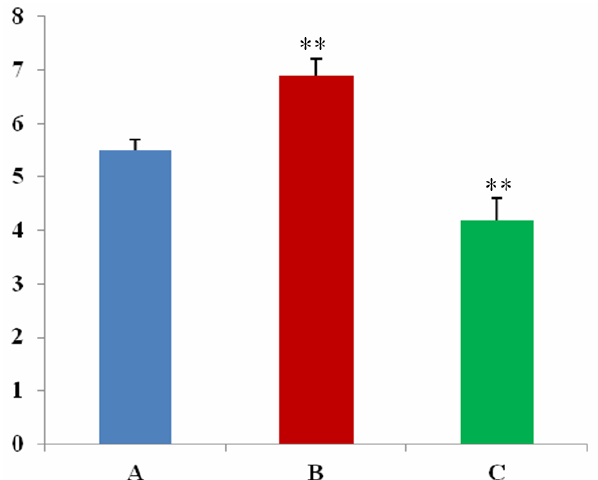
Fig. 1. Effect of lead acetate treatment (5 weeks) alone and in combination with vitamin C (500 mg/kg b.w) on the LPO lev- els in liver of rats. The values expressed as mean ± SEM (n=10). ** p Tab. 1. Protective effect of vitamin C on hepatic oxidative stress related-parameters in lead acetate-exposed rat Parameter